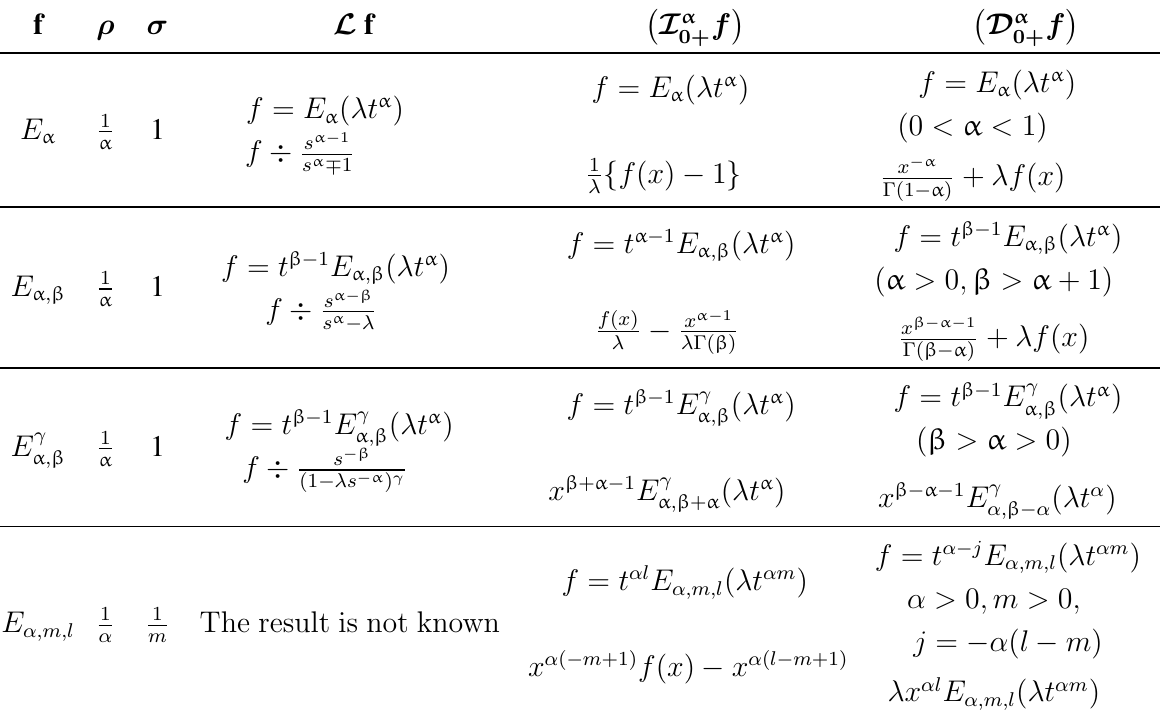
( z ) , E ( z ) , E γ ( z ) , E ( z ) α α, β α,m,l α, β